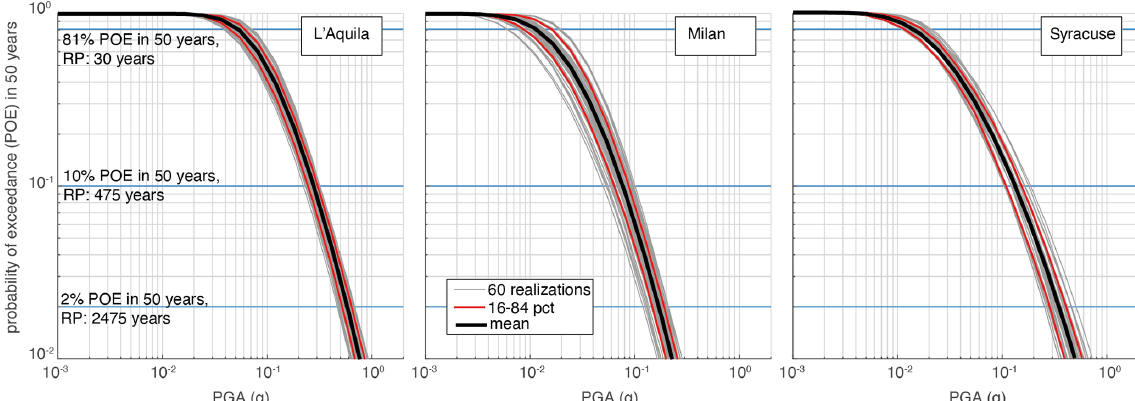
Figure 10. Hazard curves for PGA for the three selected cities. The curves represent the mean hazard level (black line), the hazard resulting from each of the 60 branches (realizations, grey lines), and the uncertainties expressed through the 16th and 84th percentiles (pct, red lines). The legend in the centre panel refers to all panels.